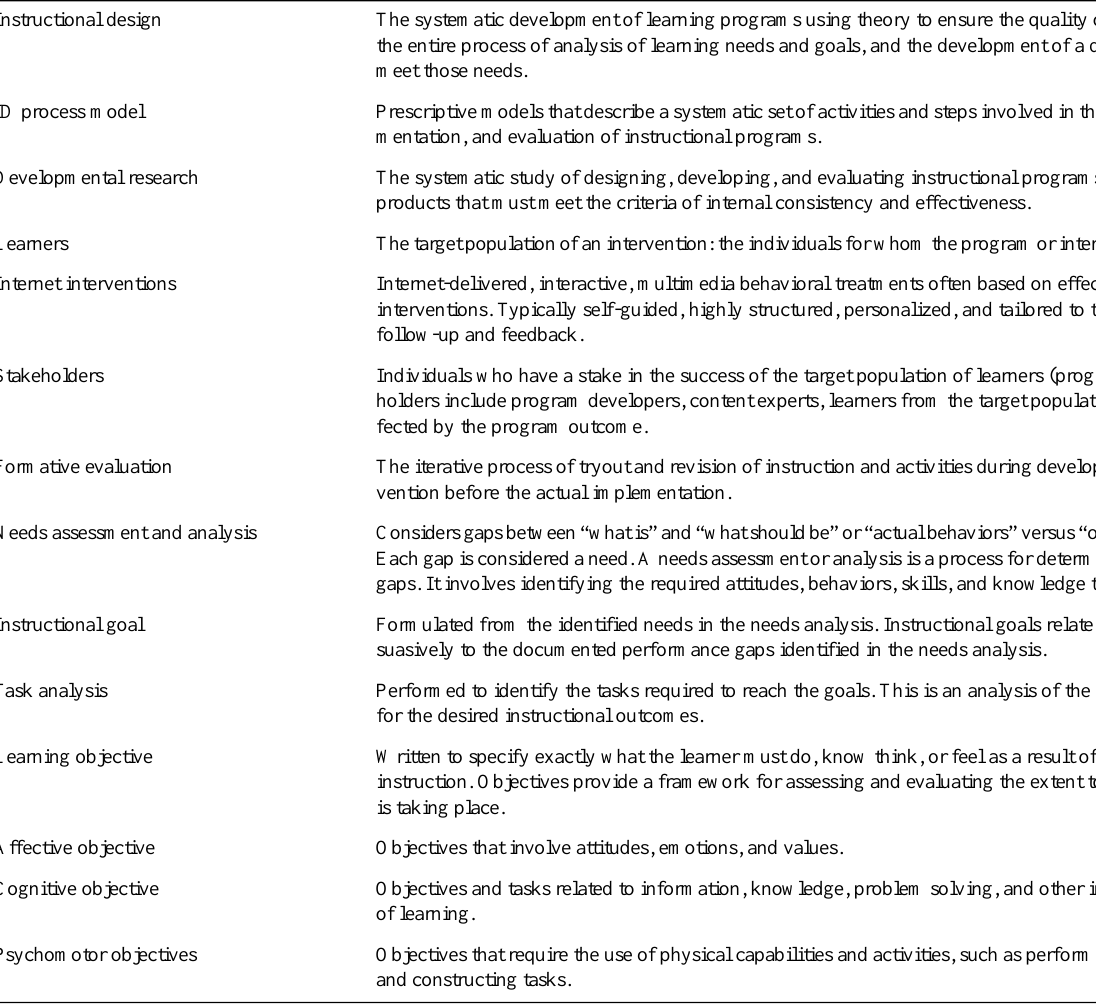
Table 1. The instructional design (ID) process: terms and definitions. The systematic development of learning programs using theory to ensure the quality of instruction. It is the entire process of analysis of learning needs and goals, and the development of a delivery system to meet